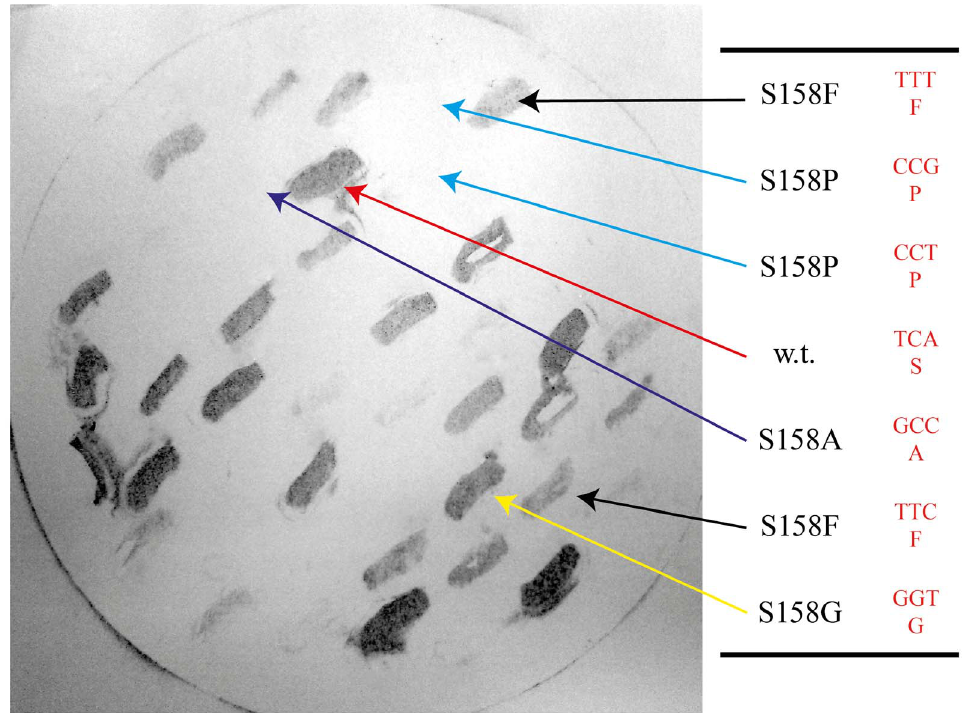
Figure 1. Colony blot results. O1 Inaba V. cholerae strain JS1569 was transformed with expression plasmids carrying different mutant wbeT genes. Different mutations in the wbeT gene give different levels of expression of the Ogawa antigen as seen by different levels of staining following labelling with Ogawa–specific antibodies. The plasmids were isolated and the wbeT genes sequenced. The mutations present in the different clones are indicated.